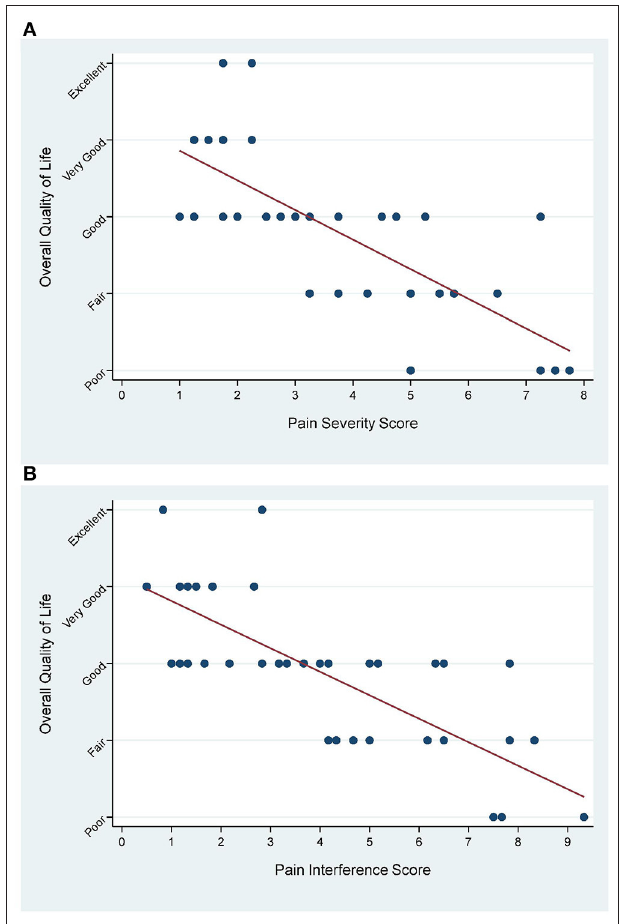
FIGURE 1 | Pearson Correlation between PSS ( A ; r = − 077) and PIS ( B ; r = − 078) with the overall QoL question ( p < 0.001 for